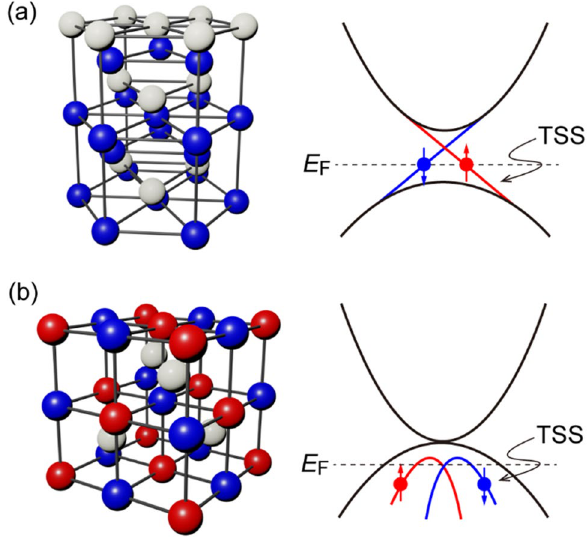
Figure 1. Comparison of the crystal structure and band structure of ( a ) topological insulator and ( b ) half- Heusler alloy topological semimetal. In the band structures, TSS indicates topological surface